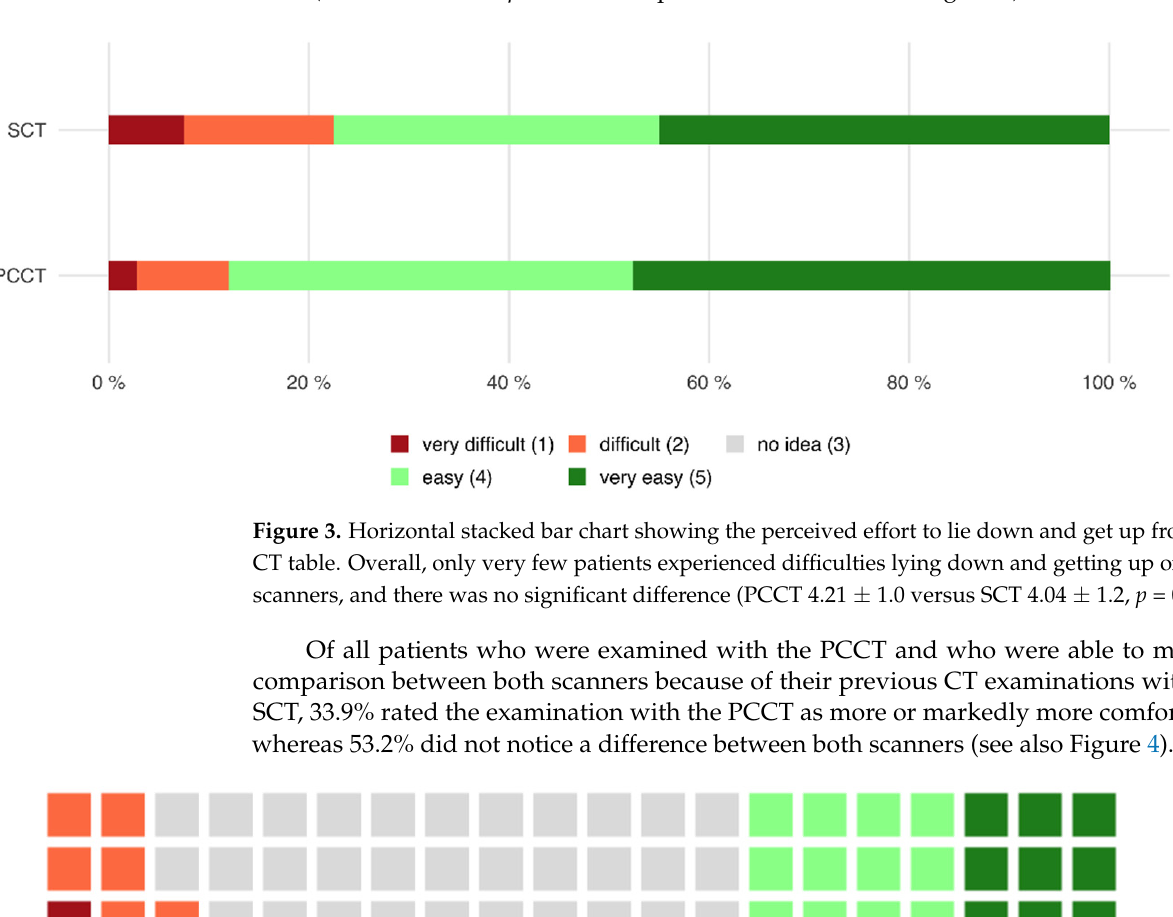
Figure 4. Waffle chart showing the comparison of both CT scanners in terms of effort to lie down and get up from the CT table. Most patients did not perceive any difference between the PCCT and the SCT (53.2 %), and 33.9 % of patients rated the examination with the PCCT as more or markedly more comfortable.